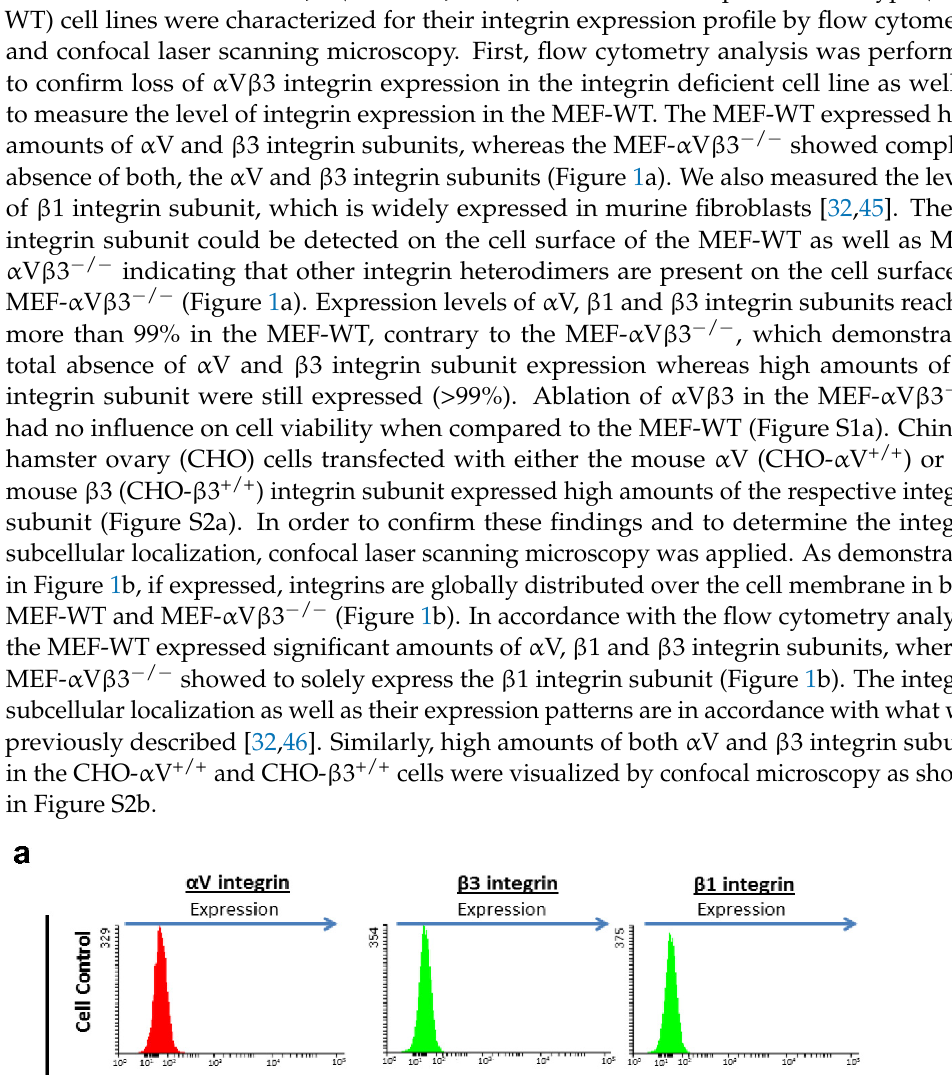
Figure 1. Integrin expression patterns in MEF-WT and MEF- α V β 3 − / − . Cells were analyzed by flow cytometry ( a ) and laser scanning confocal microscopy ( b ). In ( a ), cells were incubated with anti- integrin subunit-specific antibodies followed by incubation with secondary antibodies labelled with Alexa 647 (red histograms) or Alexa 488 (green histograms). Cell controls correspond to untreated cells. Histograms represent the mean fluorescence intensity (MFI; x -axis) and the cell counts ( y -axis). Total cell counts: 1 × 10 4 . In ( b ) cells were cultivated on coverslips and stained with integrin subunit- specific antibodies followed by incubation with secondary antibodies labelled with Alexa 488